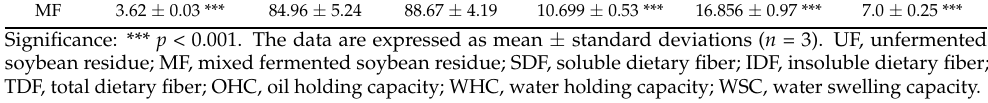
Table 5. Physicochemical properties of unfermented and mixed fermented soybean residue.